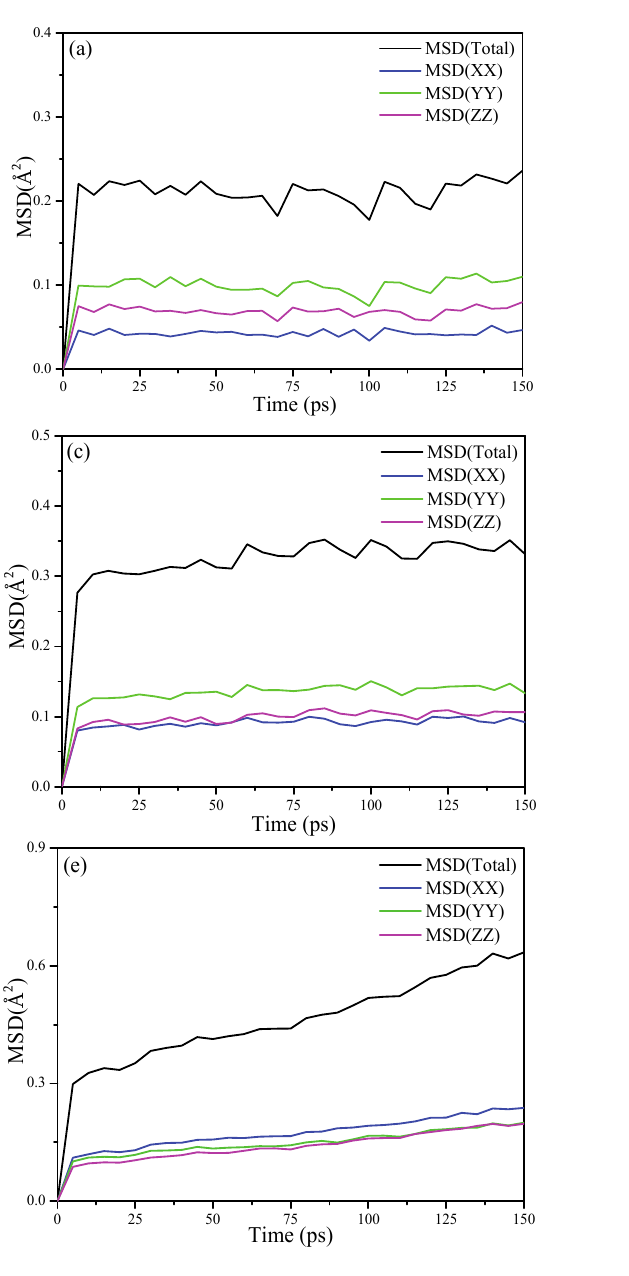
Figure 9. MSD calculated for ( a ) the oxygen atoms of KAc; ( b ) hydrogen atoms of KAc; ( c ) oxygen atoms of FA; ( d ) hydrogen atoms of FA; ( e ) oxygen atoms of DMSO and ( f ) the hydrogen atoms of